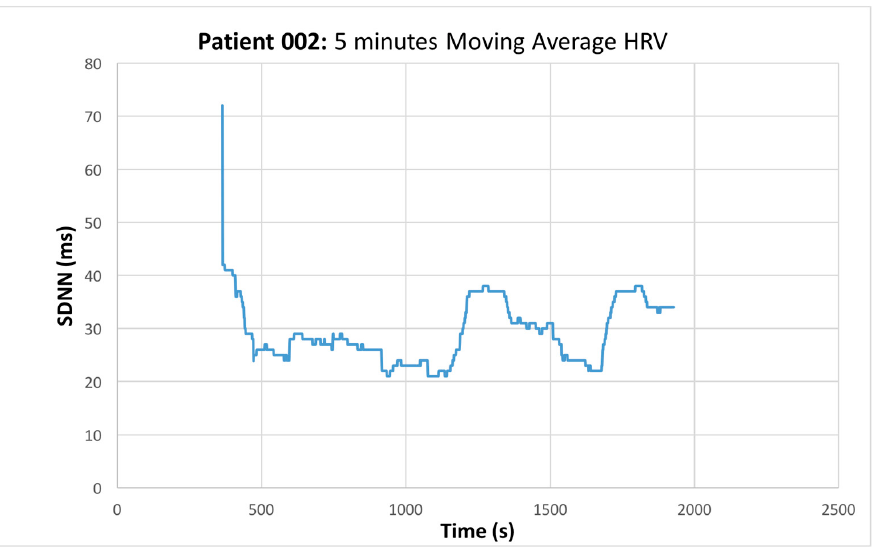
Figure 4. SDNN (ms) versus Time (s). Representative graph of the moving average measured HRV.